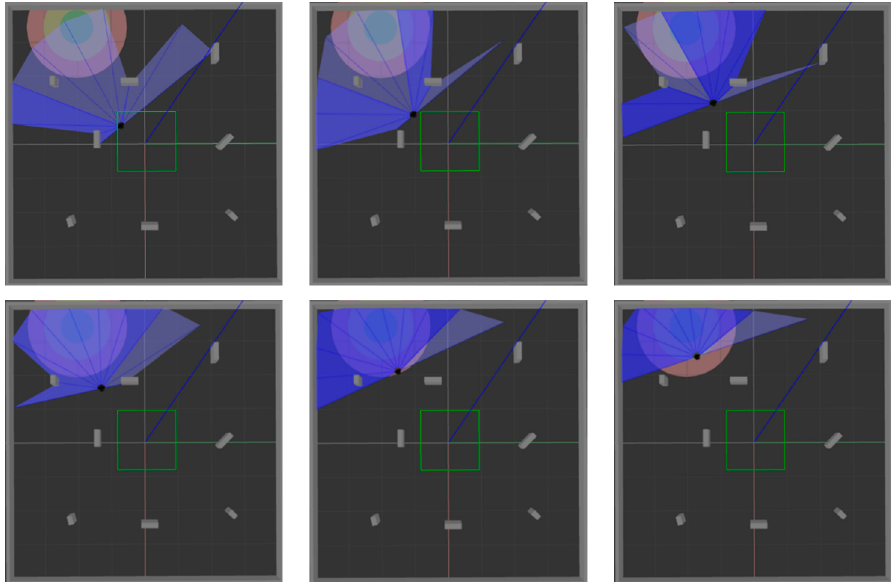
Figure 13. The motion process of the mobile robot in simulation Figure 6c.